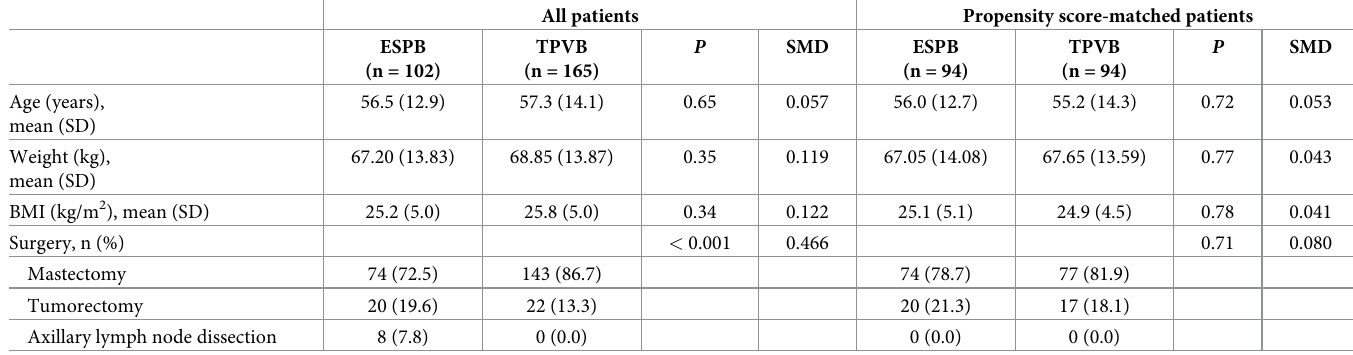
Table 1. Baseline characteristics of patients before and after propensity score matching.